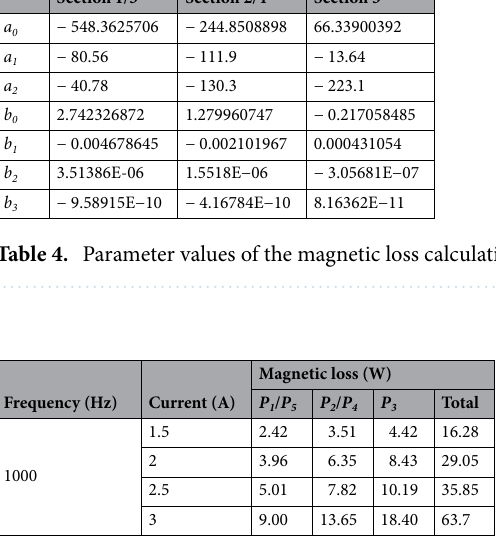
Table 5. Values of the magnetic power loss at different positions of the GMM